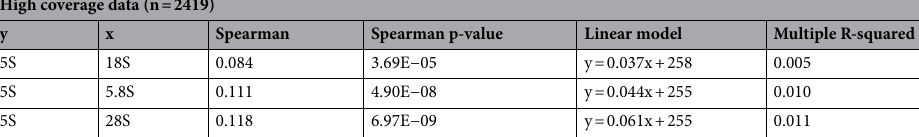
Table 2. Correlations between 45S and 5S rDNA copy numbers in the high-coverage 1000 Genomes Project dataset. The Spearman correlation coefficient and linear models that describe the relationships between the 45S and 5S rDNA copy numbers are